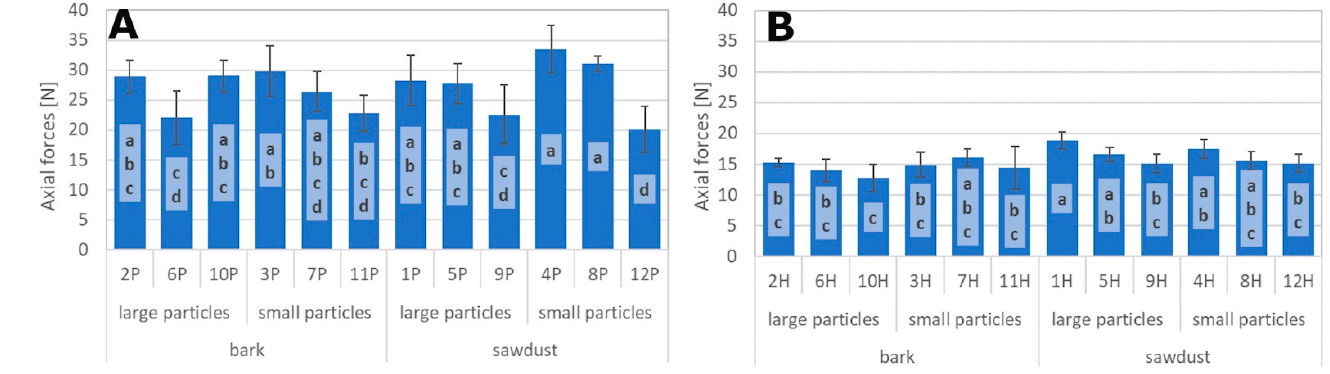
Figure 4. Values of axial forces during drilling of PLA-based composites ( A ) and HDPE-based composites ( B ) (a, b, c, d—homogeneous groups by Tukey’s test).